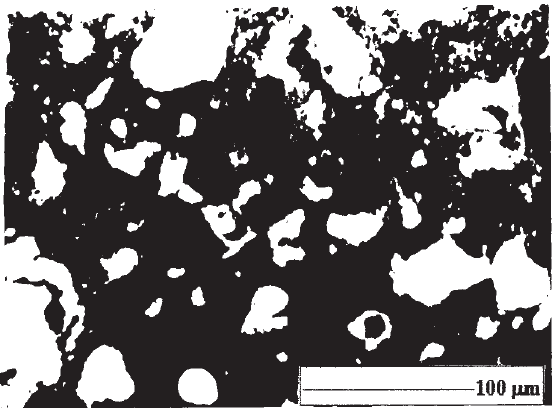
Figura 11. Agregados constituídos de plasma orgânico e inorgânico do horizonte Ap do perfil sob 18 anos de cultivo. P (poro), A (agregado), G (grão de esqueleto) (1/2 XPL).